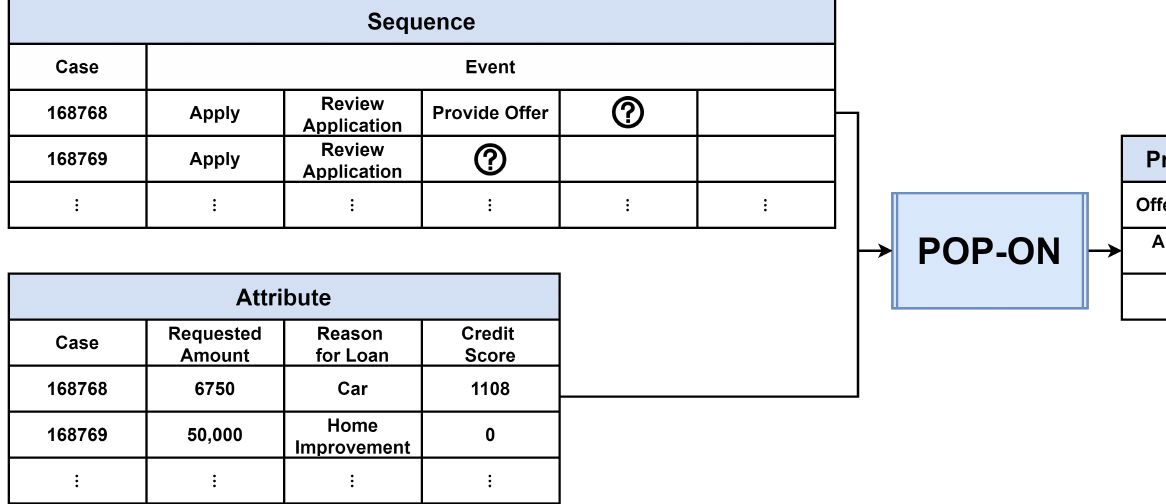
Figure 8. POP-ON explanation through a real-world